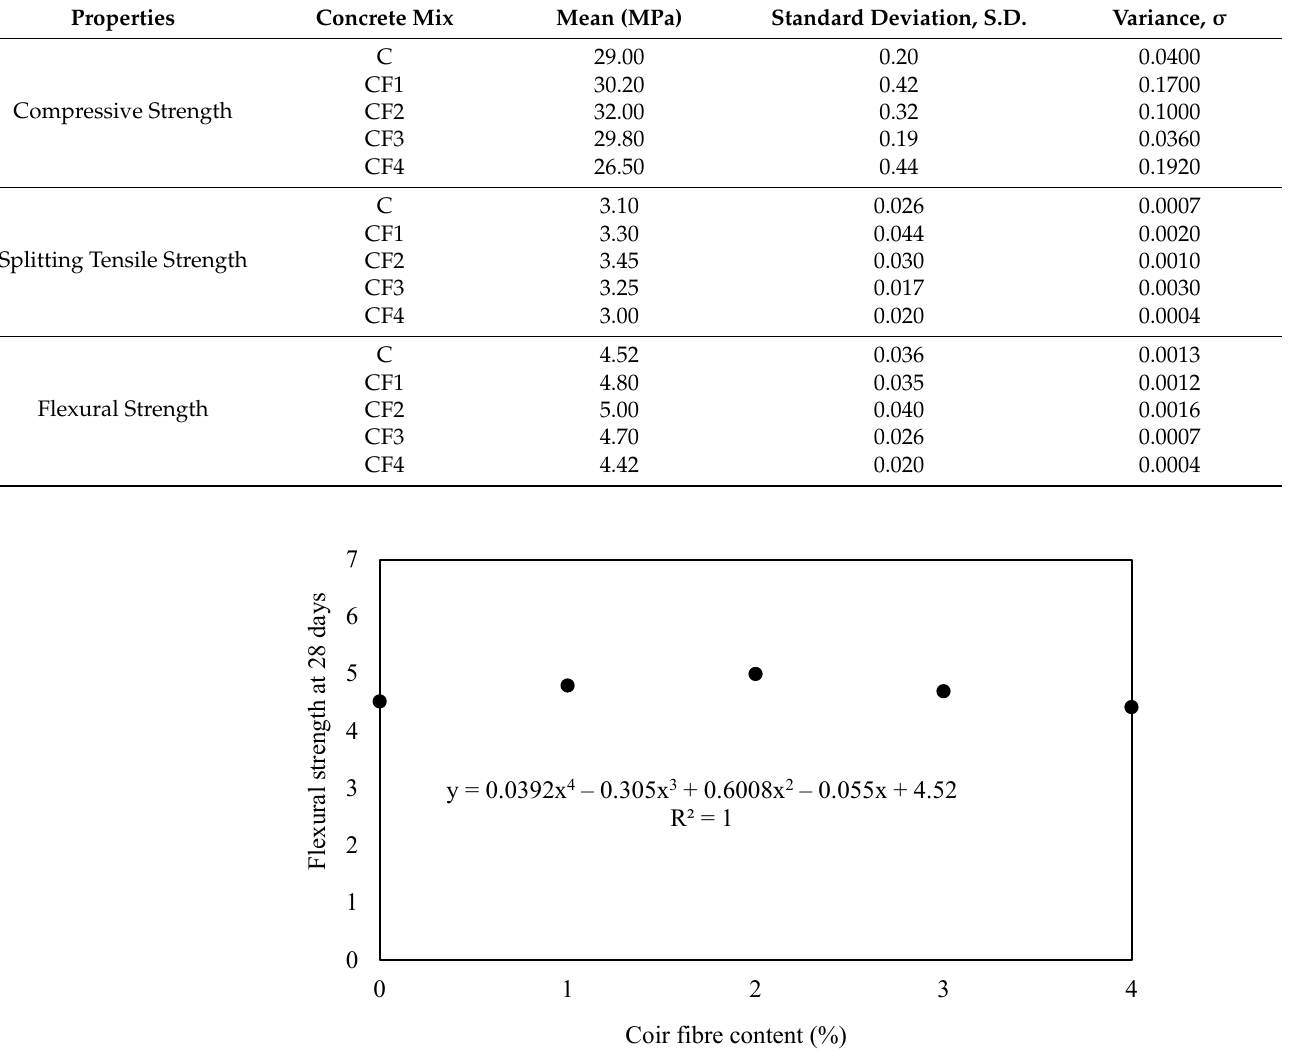
Table 8. Descriptive statistical analysis of concrete subjected to compressive, splitting tensile, and flexural strength.